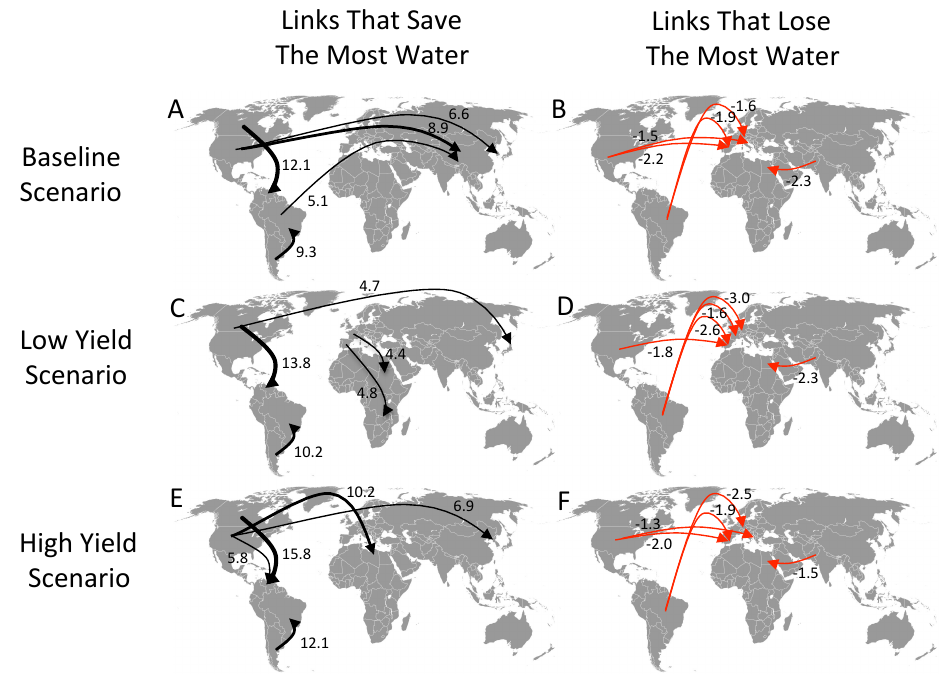
Fig. 7. Maps of the links that save and lose the most water by scenario. ( a, c, e ): the 5 links that save the most water are provided in black. ( b, d, f ): the 5 links that lose the most water are provided in red. Note that the width of the arrows has been scaled according to the volume of virtual water either saved or lost with each link. The volume of water [billions m 3 ] saved or lost with each trade link is displayed. The first row ( a, b ) illustrates the baseline scenario (i.e., 2001); the second row ( c, d ) illustrates the low-yield scenario; the third row ( e, f ) illustrates the high-yield scenario. All future climate change scenarios are for the year 2030.